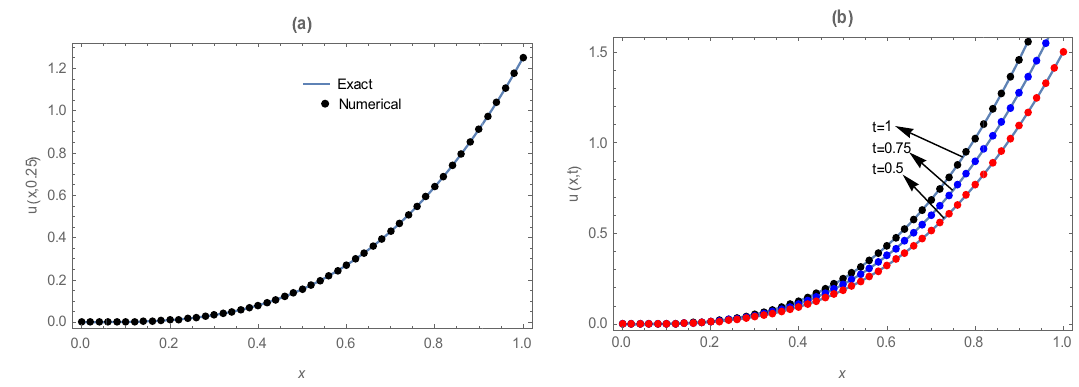
Figure 1: Graphs of approximate and exact solutions for ( a ) t 0.25 = part and ( b ) t 0.50 = , t 0.75 = , and t 1.00 = part.